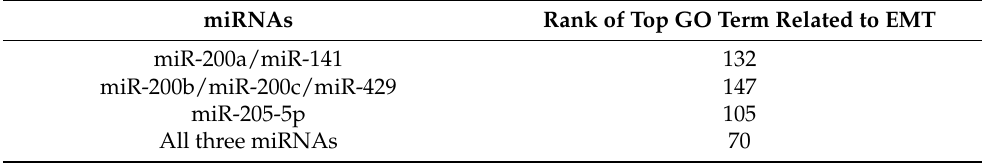
Table 4. Effect of using multiple miRNAs in capturing EMT-related GO terms. miRNAs Rank of Top GO Term Related to